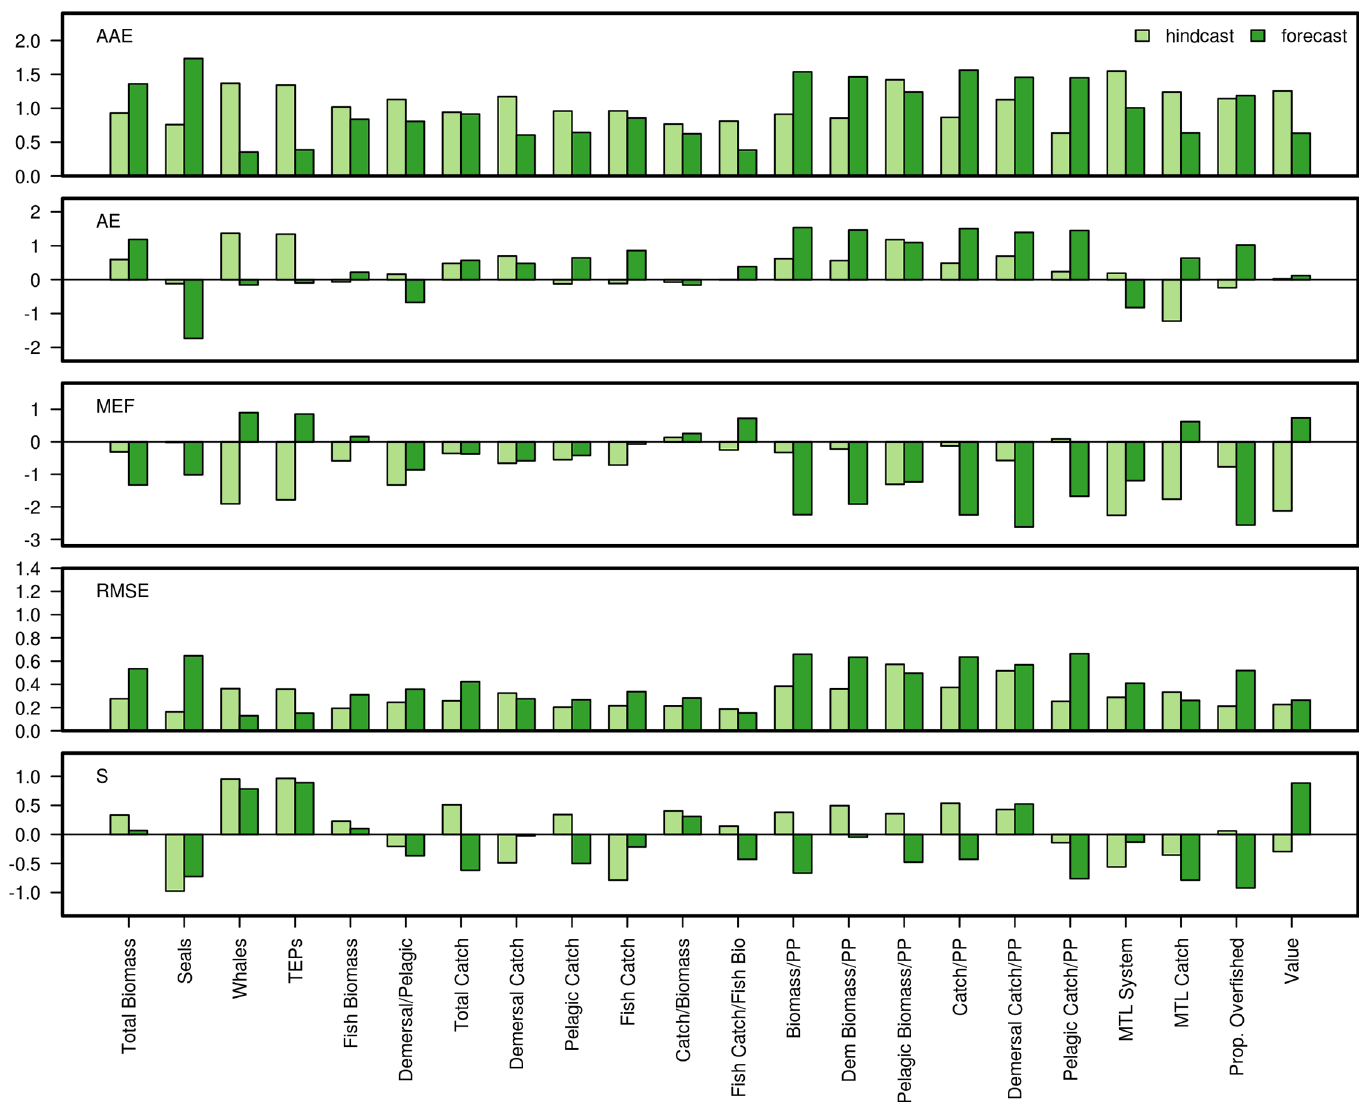
Fig 9. Forecast skill metrics for ecosystem indicators emulating emergent ecosystem properties. Pairwise comparison of forecast (_f) and hindcast (_h) skill metric performance for 5 skill metrics: MEF, AE, AAE, RMSE and S.(pearman rank) Correlation for 16 ecological indicators based on biomass and landings data. Y-axis limited to show values between -2 and